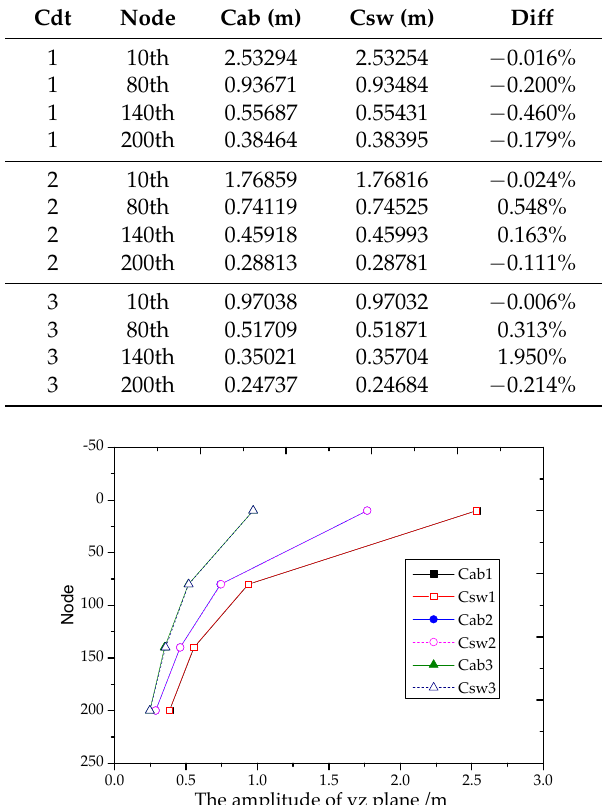
Figure 10. Amplitude change with water depth.